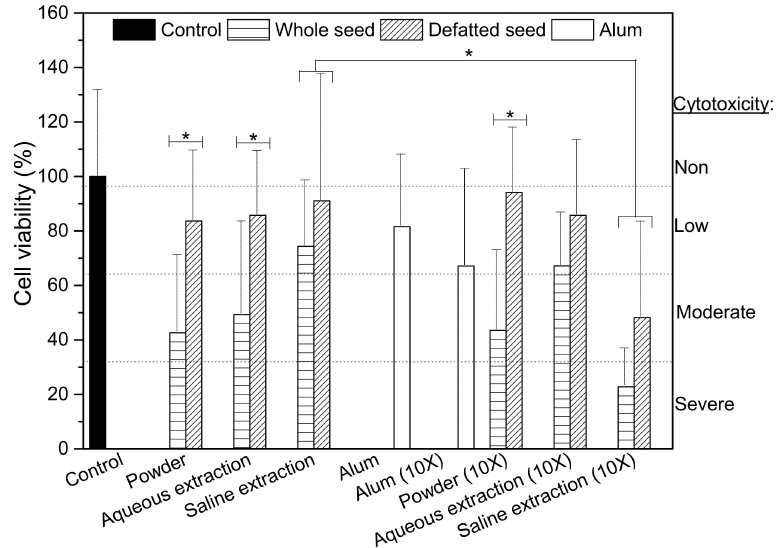
Figure 7. Viability (% in relation to control group) of Vero cells after 24 h of exposure to Moringa oleifera seed-derived and alum coagulants in deionized water—optimal dosage (Table 3) and 10 × optimal dosage. * Indicates significant differences between the groups regarding oil extraction or dosage (Mann-Whitney test, p <